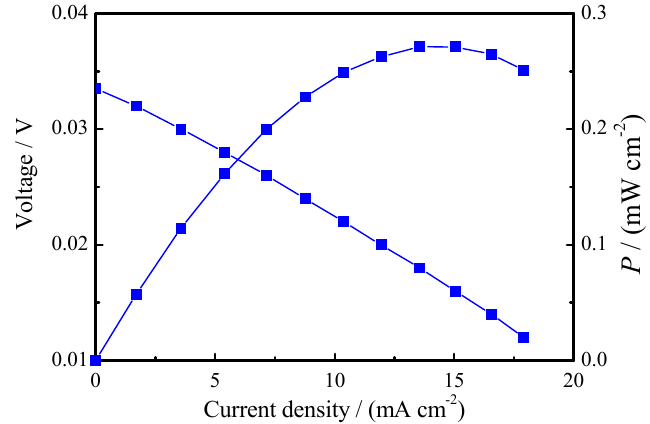
Figure 5. The oxygen concentration discharge cell: air, Pd-Ag|8YSZ+4Yb 2 O 3 -NaCl/KCl (800 °C)|Pd-Ag, O 2 at 700 °C.